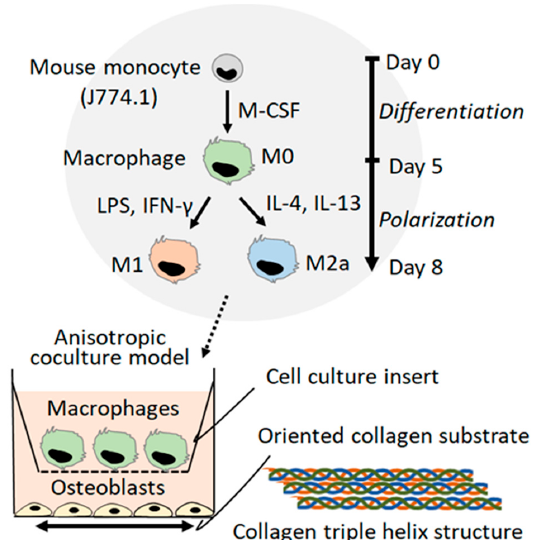
Figure 1. A novel co-culture platform combining the anisotropic cultivation of osteoblasts on oriented collagen substrates and the controlled polarization of macrophages is shown.